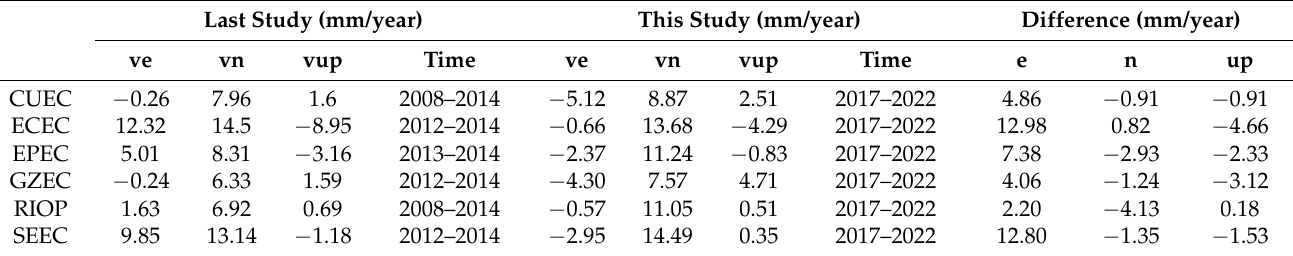
Table 3. Differences between rates from Luna [3] and this